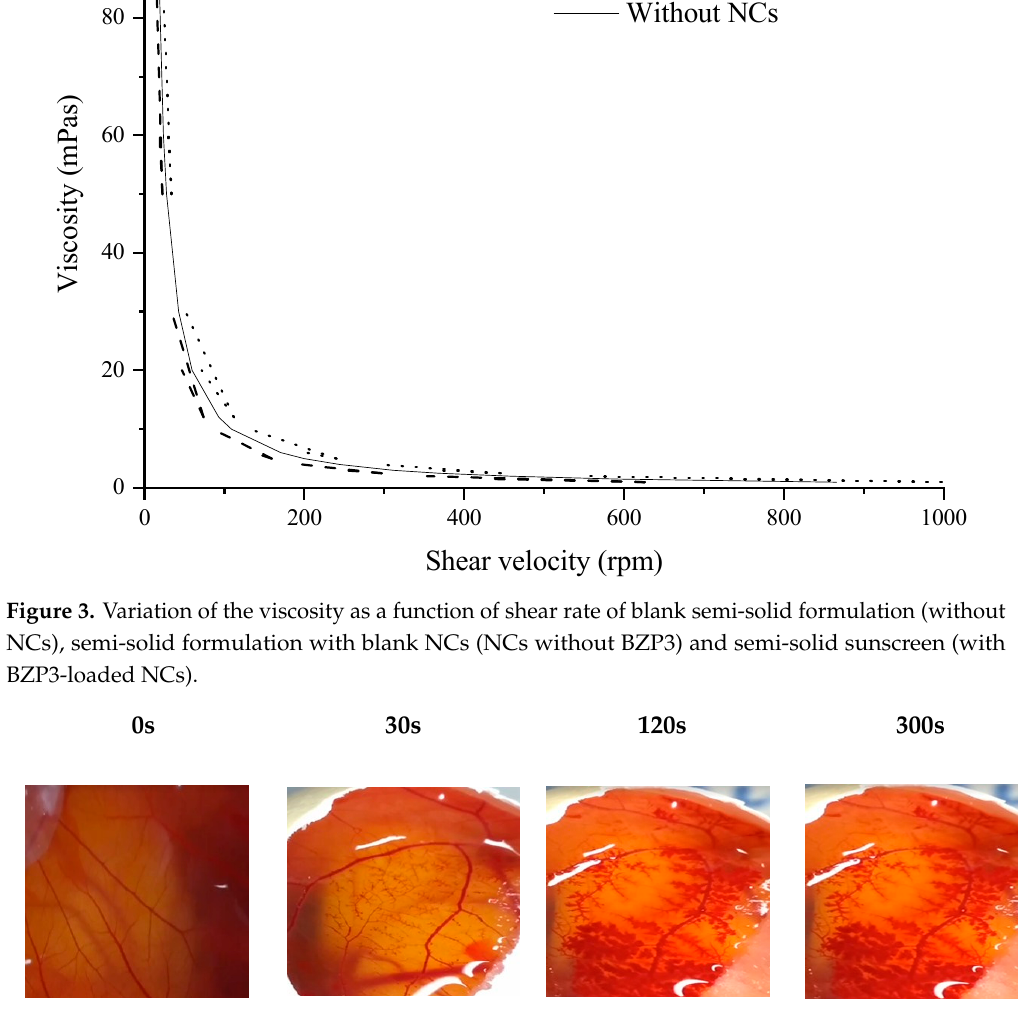
Figure 3. Variation of the viscosity as a function of shear rate of blank semi-solid formulation (without NCs), semi-solid formulation with blank NCs (NCs without BZP3) and semi-solid sunscreen (with BZP3-loaded NCs).